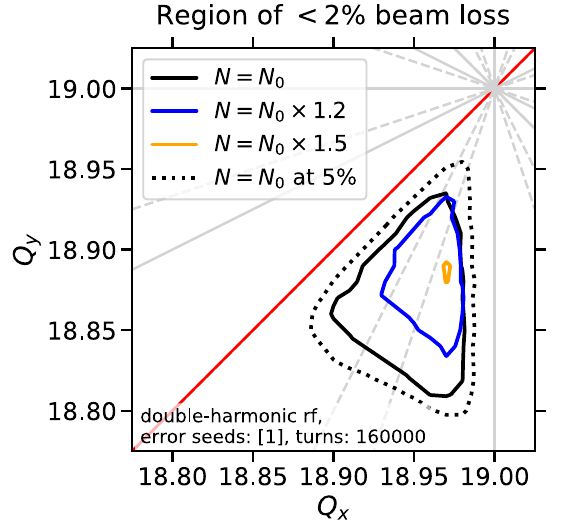
FIG. 18. Space charge limit for double-harmonic rf operation. The solid contour lines enclose the tune area with less than 2% beam loss after the injection plateau for various beam intensities, obtained from the FFSC simulation model with the magnet field errors included. The dotted contour line shows the reference 5% beam-loss threshold as in Fig. 17.